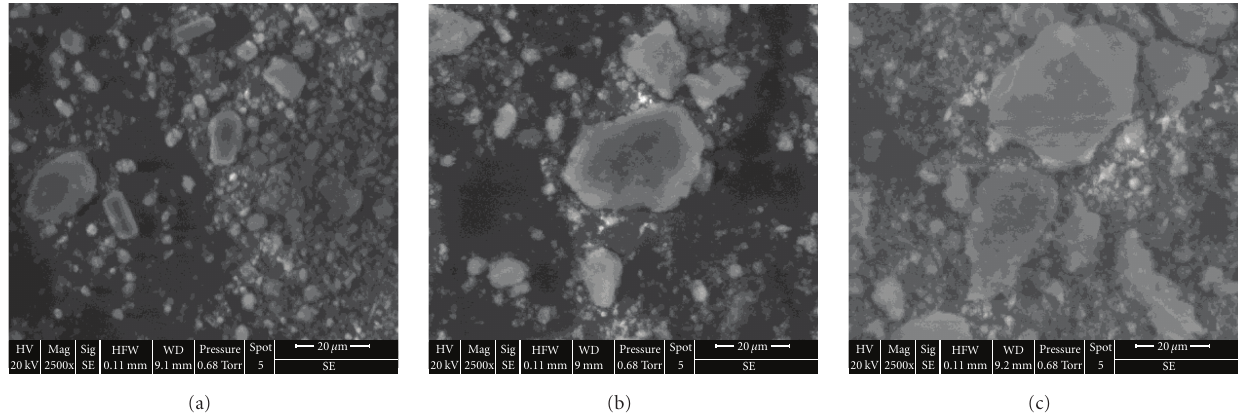
Figure 4: SEM micrographs of M x FA samples: (a) x = 0, (b) x = 1, and (c) x = 2.